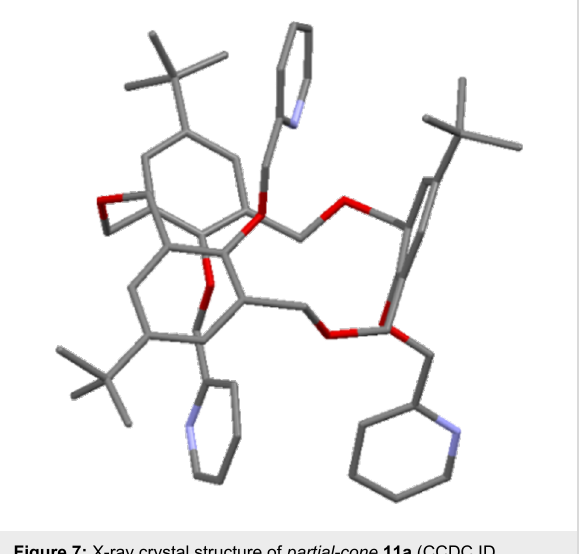
Figure 7: X-ray crystal structure of partial-cone 11a (CCDC ID 150580)